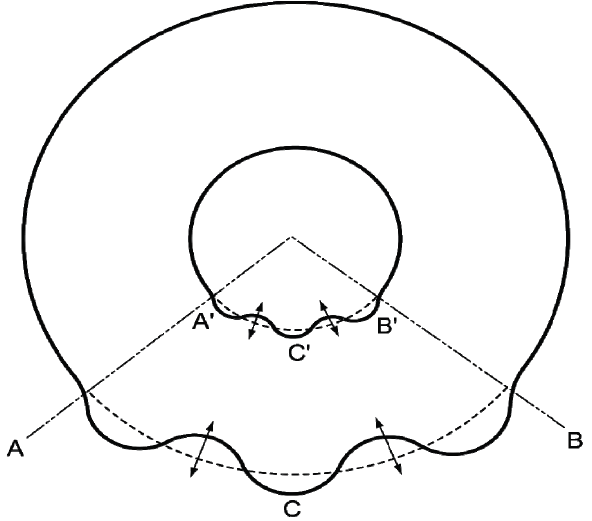
Figure 13. Partial chevron nozzle with rotation. The partial chevron nozzle [417]: (i) has chevrons over the angular sectors where the noise disturbance is to be reduced by spectral and directional broadening (Figures 5 to 9); (ii) there are no chevrons in other angular sectors, allowing sound to escape in other “harmless” directions. During take-off and landing the angular sectors with chevrons are used to reduce fly-over and sideline